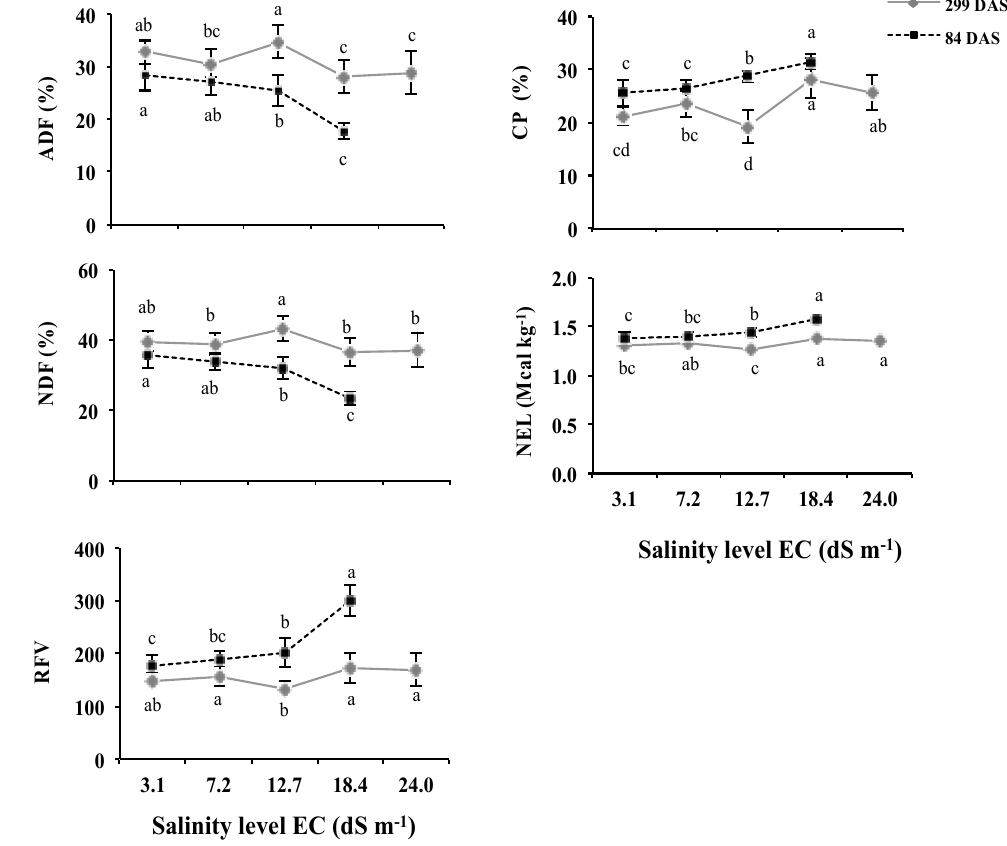
Figure 1. Impact of salinity increase on acid detergent fiber (ADF), neutral detergent fiber (NFD), net energy of lactation (NEL), crude protein (CP), and relative feed value (RFV) of salt-tolerant alfalfa. Data points represent the means (±SD) of the salinity-tolerant cultivars ( n = 8). Means with the same letter are not significantly different according to a Fisher LSD test ( p ≤ 0.05). For the harvest at 84 DAS, the lack of data at 24 dS·m − 1 was due to there being insufficient plant material for analysis because of growth